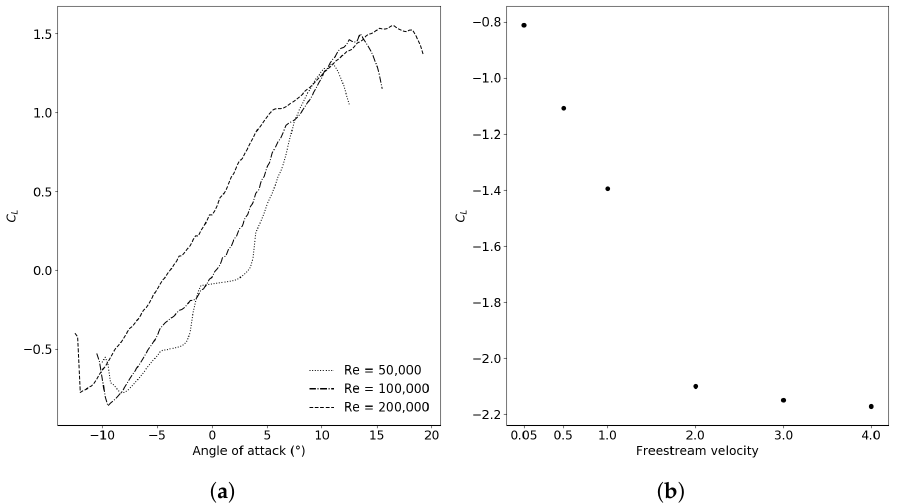
Figure 6. Evolution of the lift coefficient: at different Reynolds numbers for the LS(1)-0417 ( a ); and at different freestream velocities for the baseline geometry ( b ).